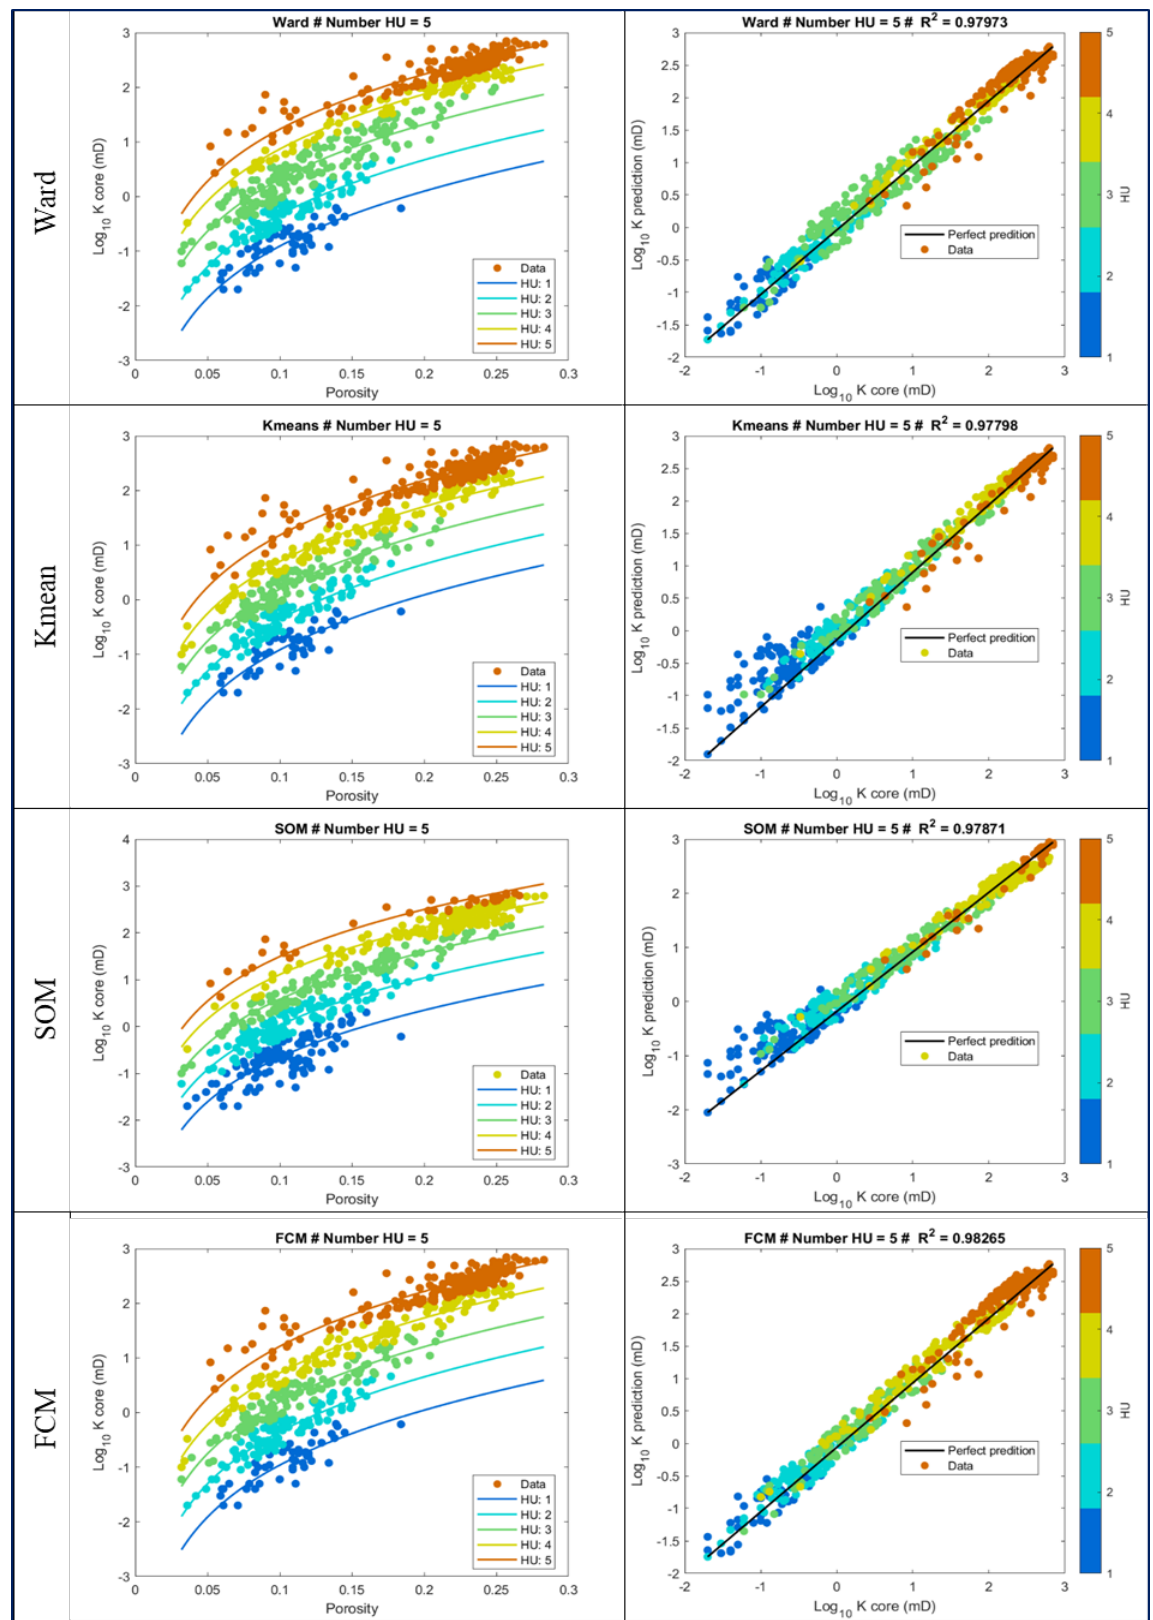
Figure 7. The matrix cross plots between (K_core vs. PHI_core) and (K_core vs. K_pre) of four unsupervised machine learning methods show that the reservoir is divided into 5 HU groups.